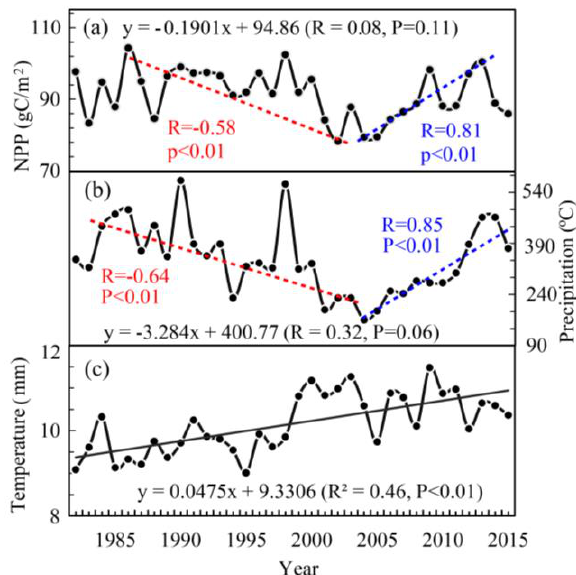
Figure 6. Annual variation of NPP and climate parameters in Mongolia from 1982 to 2015: (a) mean annual NPP; (b) annual accumulated precipitation; and (c) annual mean temperature. Decreased trend by red lines and increased trend by blue lines with the linear regress for each stage. There were notable spatial differences in the correlation coefficients between the mean NPP during the growing seasons and the annual temperature and precipitation. In general, NPP was negatively correlated with air temperature and positively correlated with precipitation in the most part of Mongolia (r=0.6-0.8, p<0.01) (Figure 8a).